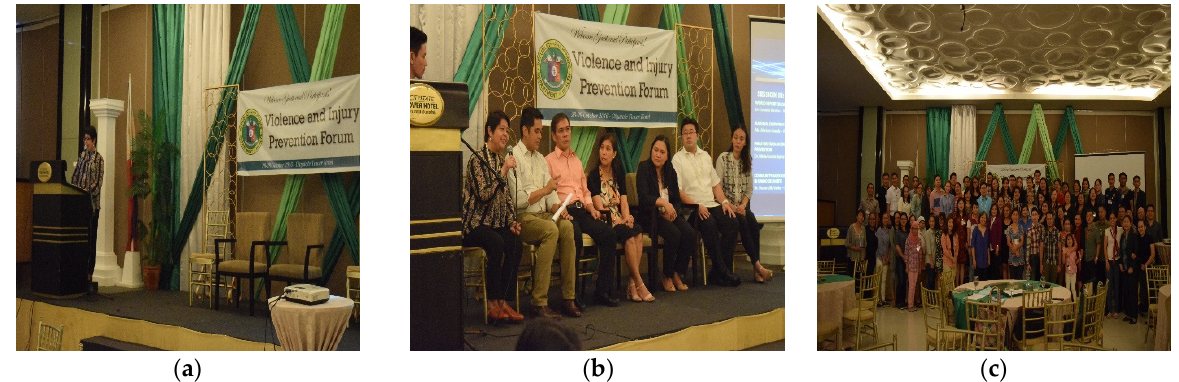
Figure 3. Public hearing on the Multisector Action Plan on Drowning Prevention in the Philippines: ( a ) presentation of the Multisector Plan on Drowning Prevention in the Philippines, 2016–2026; ( b ) panel addressing questions from the participants; ( c ) group photo of the participants who attended the public hearing.